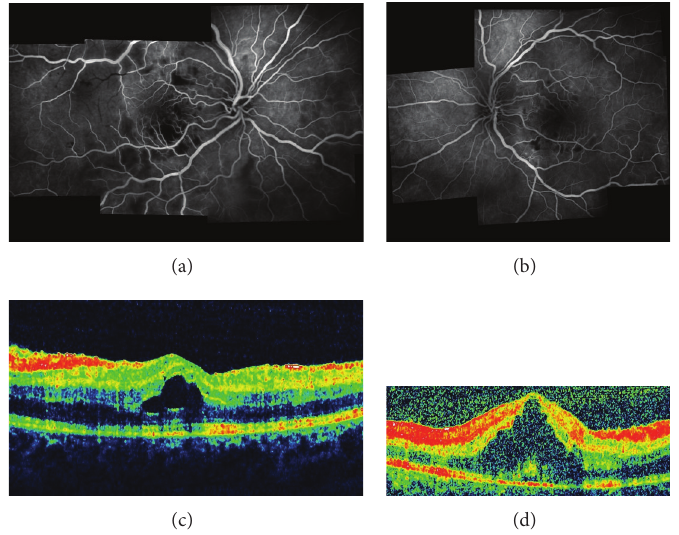
Figure 2: (a) Right eye, composite fluorescein angiogram demonstrating extensive capillary nonperfusion and arteriolar occlusion. (b) Left eye, composite fluorescein angiogram showing capillary dropout areas at the posterior pole. (c) Right eye, OCT picture demonstrating serous macular detachment. (d) Left eye, OCT picture exhibiting serous macular